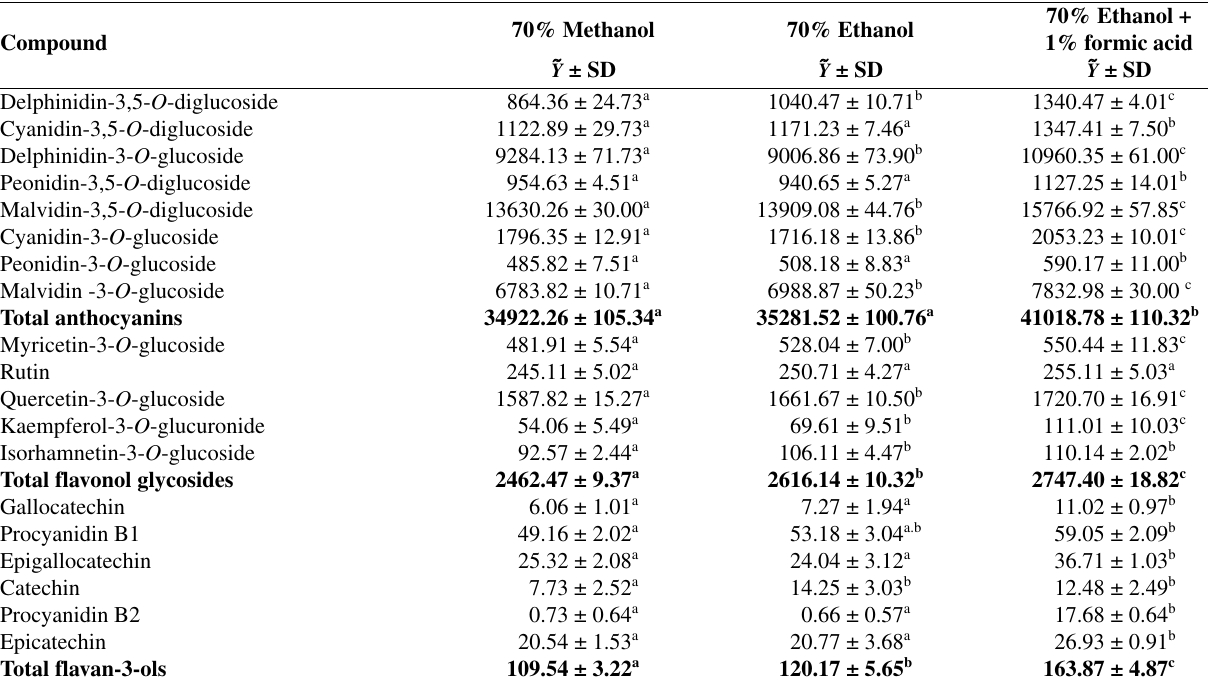
Table 2. Effect of the extraction solvent composition on the contents of individual flavonoids from grape skins. Results are expressed as mg kg –1 dry weight of grape skin 70% Methanol